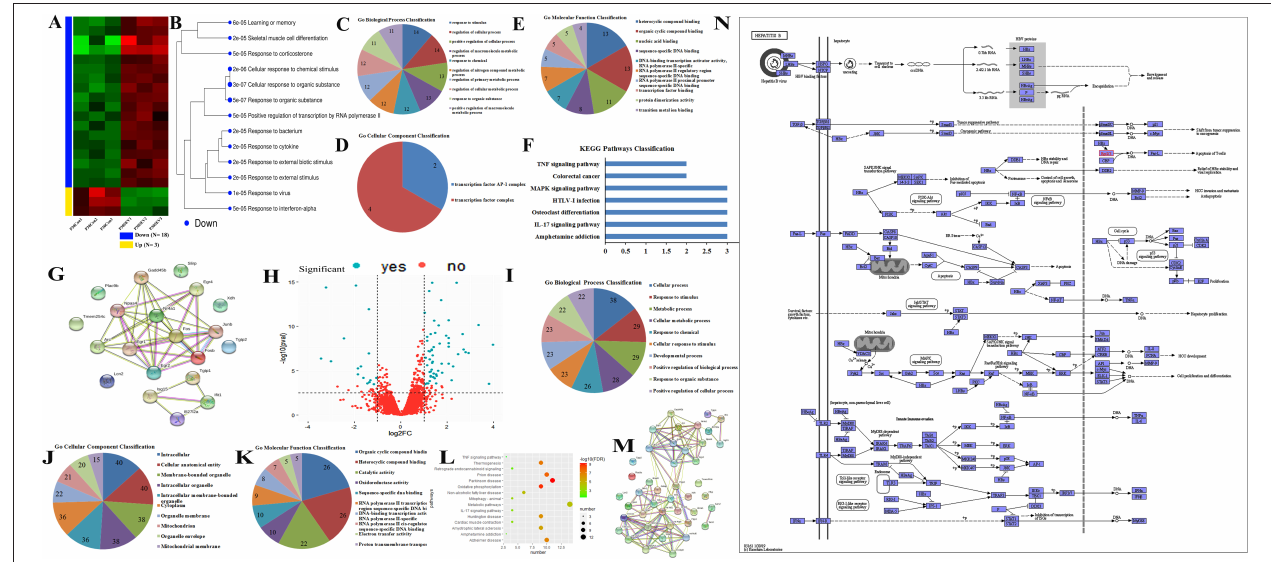
FIGURE 3 | GO/KEGG analysis for differential expression genes (DEGs) and mitochondria-related genes. (A,B) Cluster analysis of DEGs for heatmap and dendrogram; (C–F) GO terms and KEGG pathways analysis of DEGs; (G) PPI network construction for DEGs; (H) the volcano plot for displaying the distribution of DEGs; (I–K) GO function analysis for gene sets including DEGs and mitochondria-related genes; (L) bubble plot showed the signal pathways of gene sets; (M) PPI network construction for gene sets; (N) presentation for involving in signal pathway.